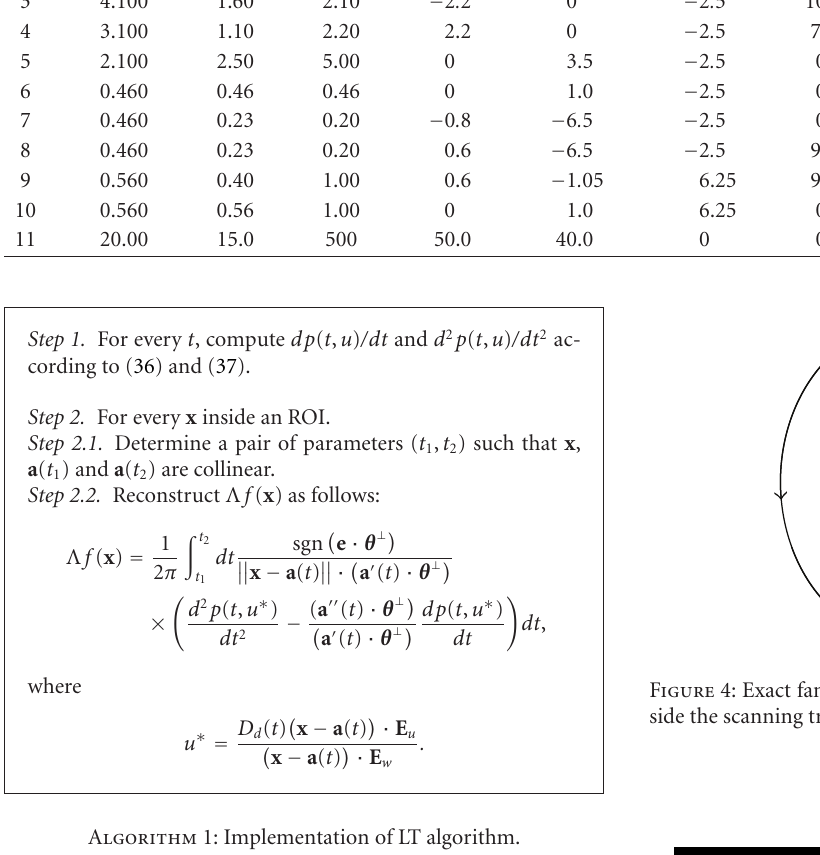
Algorithm 1: Implementation of LT algorithm.